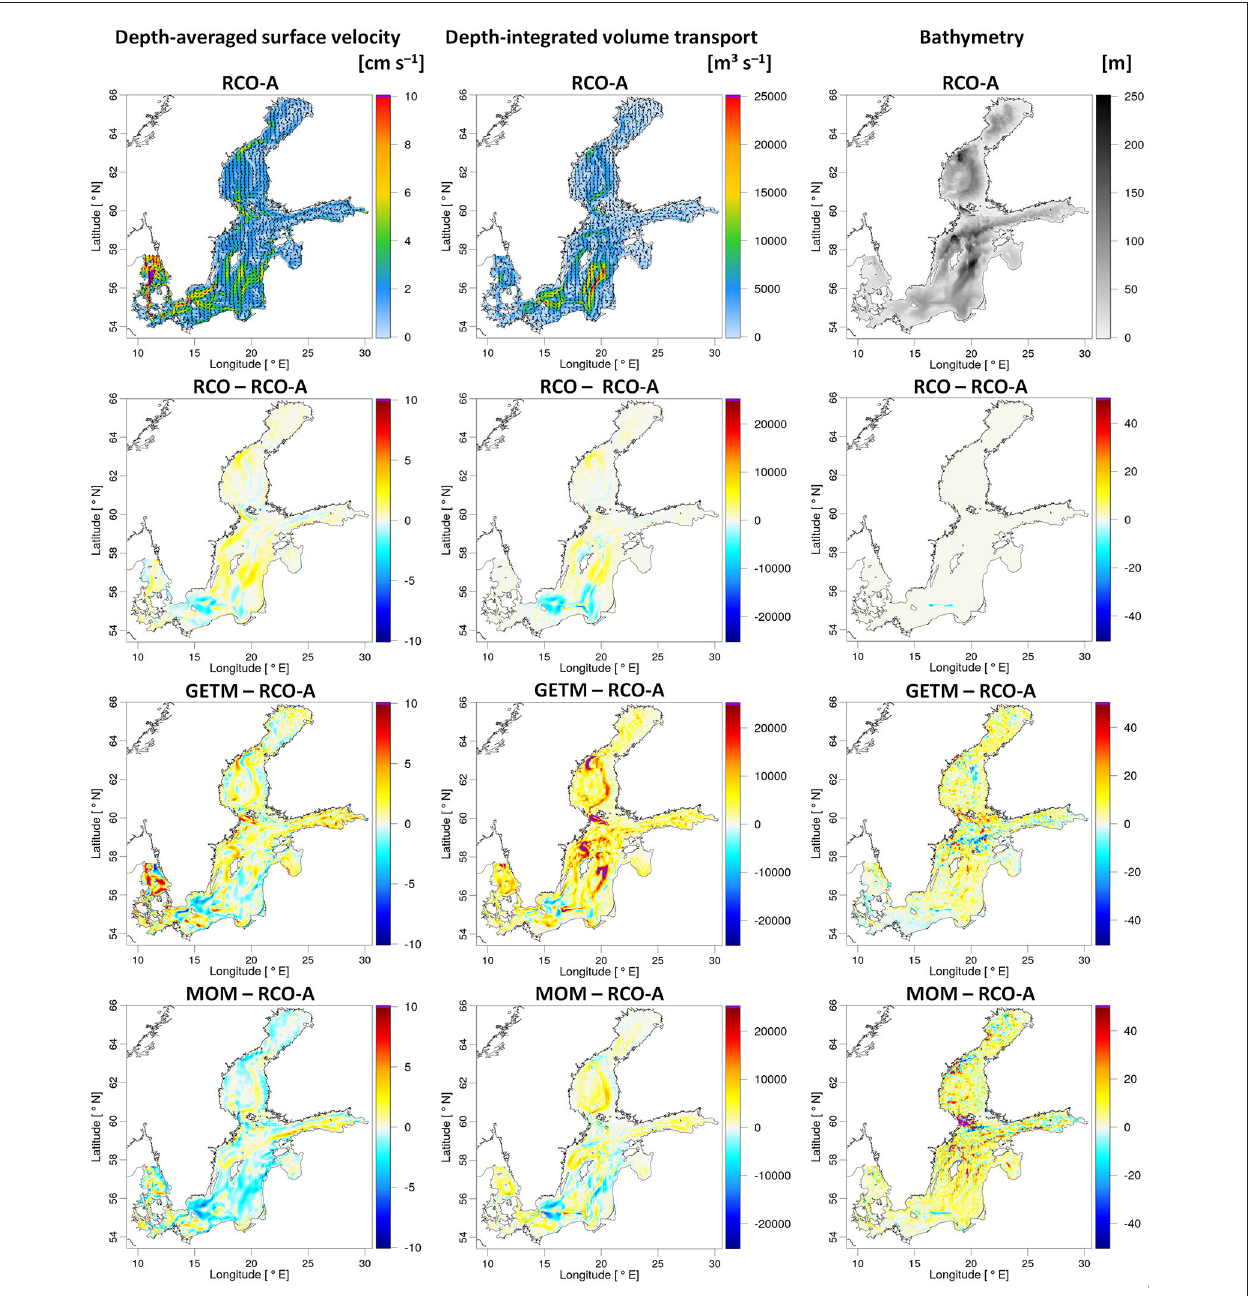
FIGURE 7 | Thirty-year mean surface velocity averaged from the Baltic Sea surface down to 10m depth ( left ) and volume transport integrated from the surface to the bottom ( middle ) as well as the used model bathymetry ( right ) for the years 1970 through 1999. In the top panels absolute values from the model RCO-A are displayed. Arrows show the direction of velocity and transport, respectively, at every 5th model grid point. The panels below show the differences of the individual models RCO, GETM, and MOM from RCO-A, respectively. Values exceeding the maximum positive plotting range are drawn in purple.